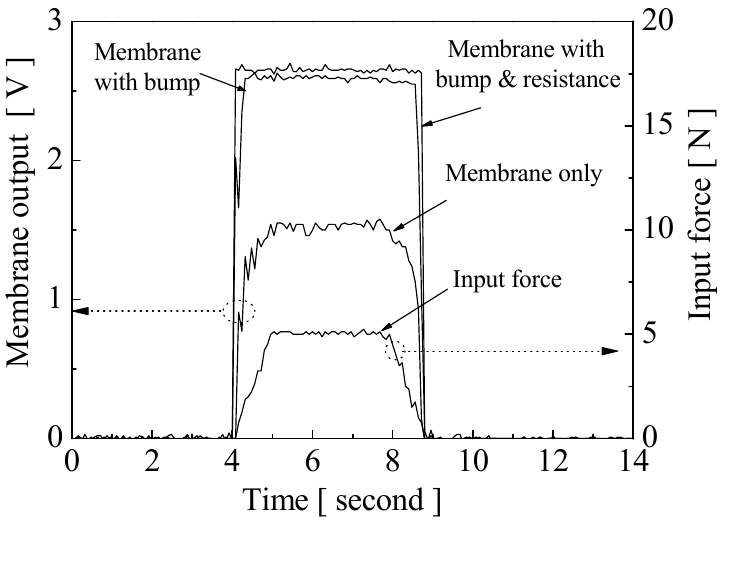
Figure 8. Comparison of the dynamic response effects of the membrane without bump, with bumps, and with bumps and a resistance